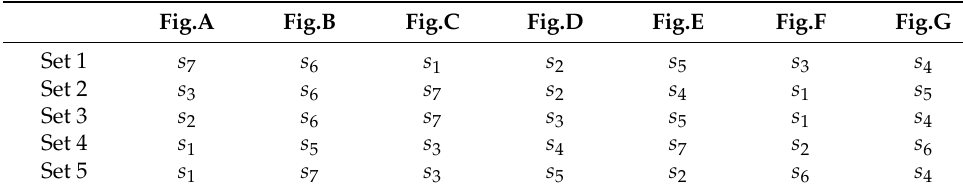
Table 3. Answers for calibration experiment of DM 3 .